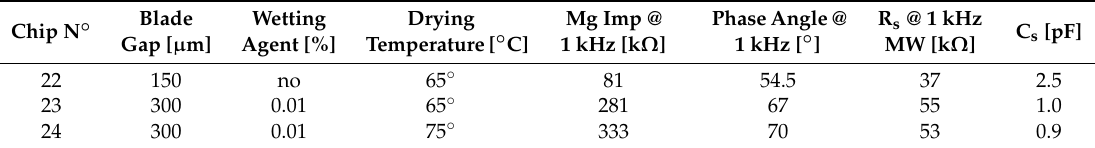
Table 2. Variation of application parameters for